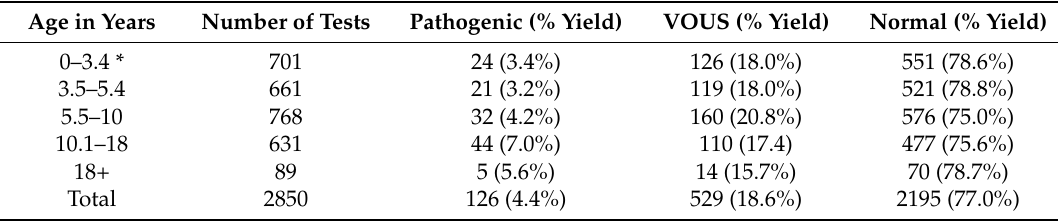
Table 6. Diagnostic yield by age in patients with only ASD indicated (569 (20.0%) females, 2281 (80.0%) males, Total n =